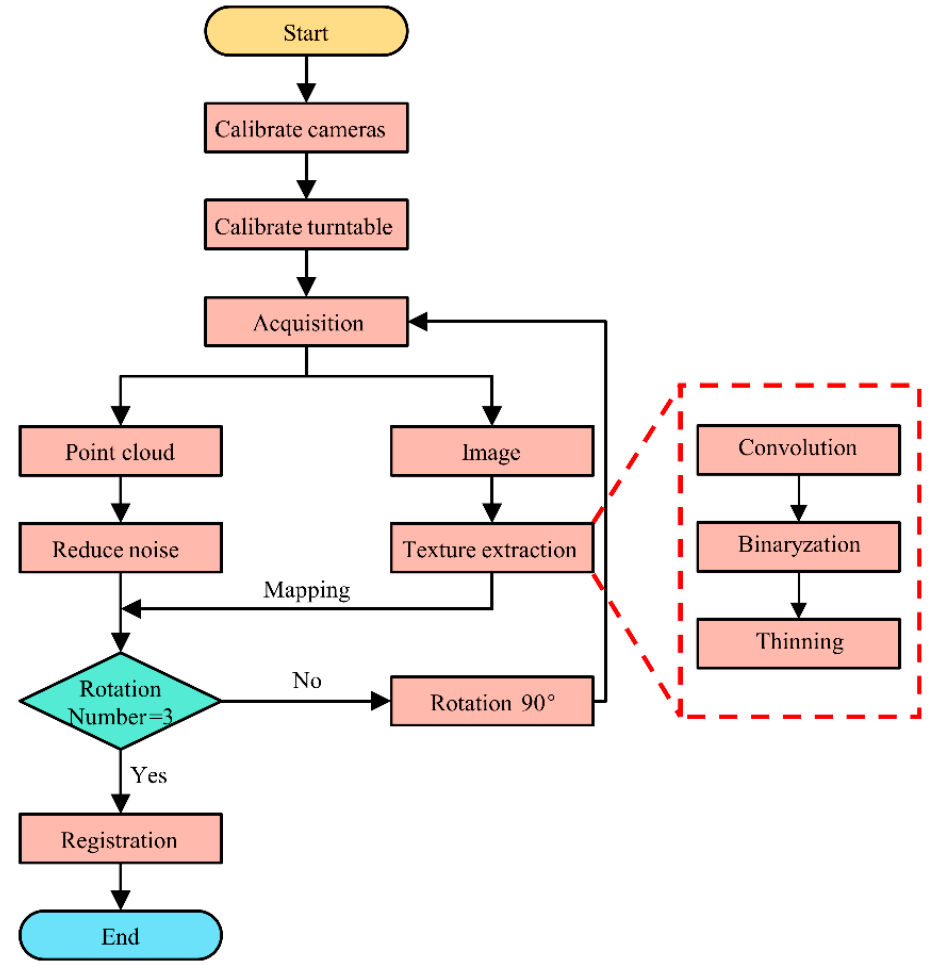
Figure 3. Flow chart of detection algorithm for yarn orientation.